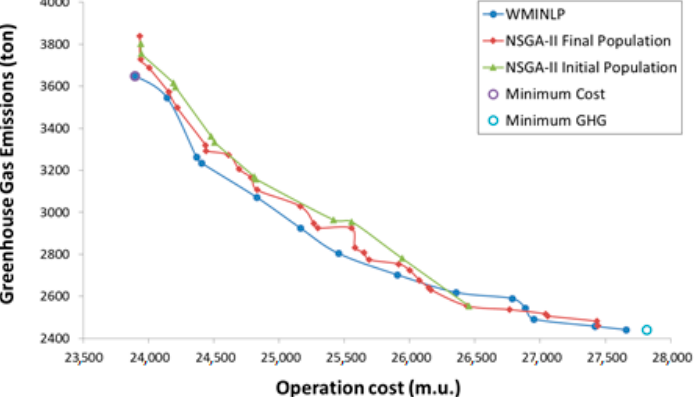
Figure 5. Pareto front of min(Cost, GHG).